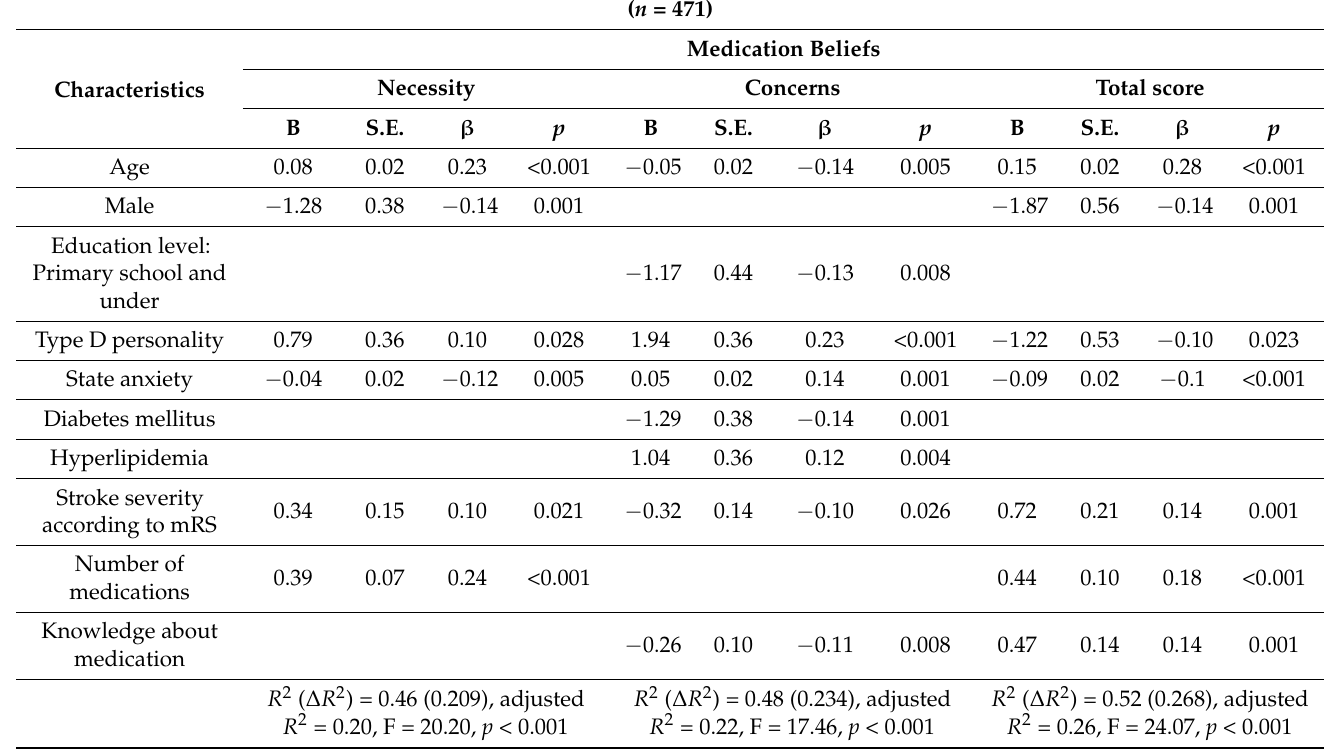
Table 2. Factors influencing medication beliefs of ischemic stroke patients. ( n =